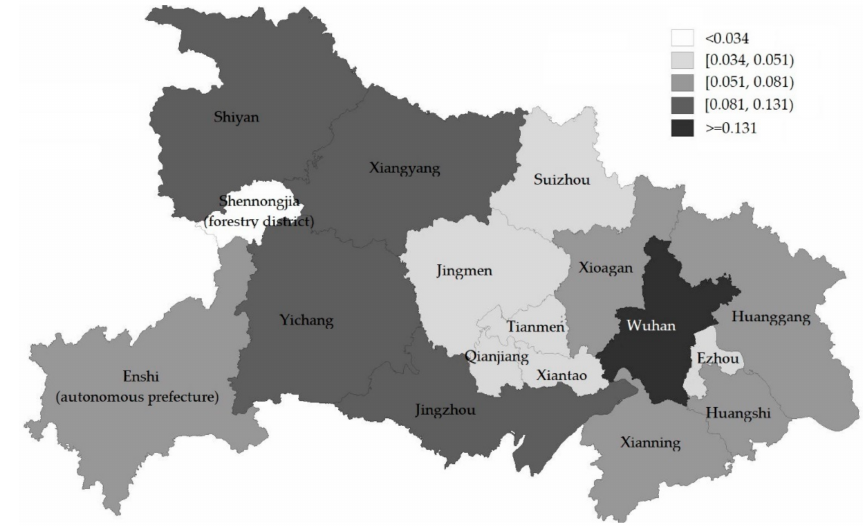
Figure 8. Classification of local emergency resilience across regions.